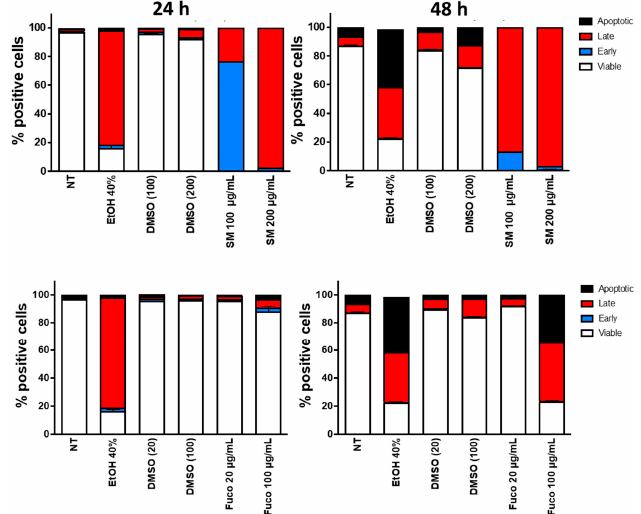
Figure 3. Effects of S. marinoi extract and fucoxanthin in vitro on the induction of apoptosis in DU145 PCa cell line. Cells were treated for 24 and 48 h with Sm (100 and 200 µg/mL) and Fuco (20 and 100 µg/mL). The e ff ects on induction of apoptosis were evaluated by fl ow cytometry (FACS analysis) following labeling with Annexin V/PI. Data are represented as bar graphs ( n = 2). Control (not treated cells), EtOH (ethanol used at 40% as positive control), and DMSO (vehicle control used to dissolve Sm and Fuco). 3.3. E ff ect of S. marinoi Extract and Fucoxanthin on Vascular Mimicry of PCa Cells Sm (100 µg/mL) and Fuco (20 µg/mL) treatments on DU145 cells plated on Matrigel